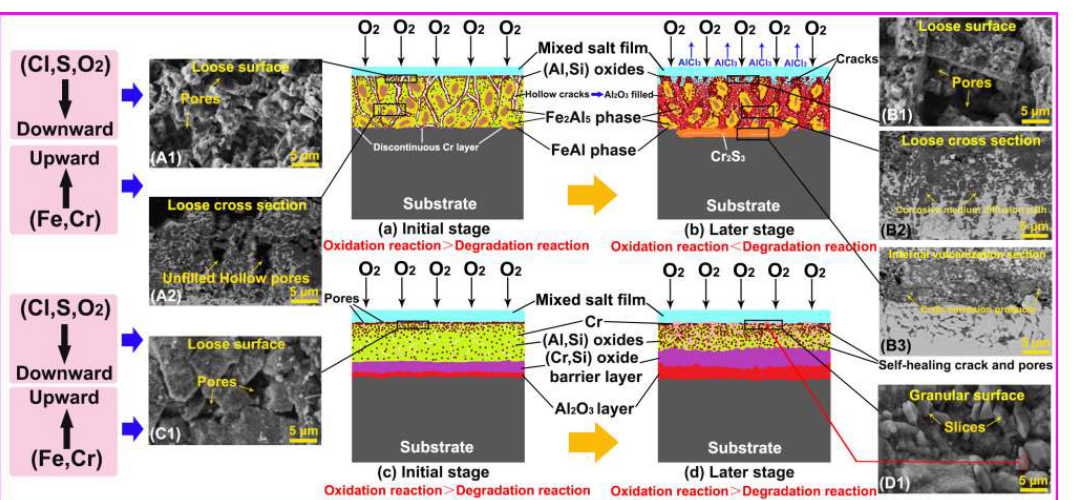
Figure 7. Schematic diagram of the degradation damage mechanisms of the as-deposited coatings during the hot-salt corrosion tests: ( a , b ) M1; ( c , d ) M2; SEM images of the surface of sample M1 after 100 h and 200 h hot salt corrosion: ( A1 ) and ( B1 ), SEM images of the cross section of sample M1 after 100 h and 200 h hot salt corrosion: ( A2 ) and ( B2 , B3 ); SEM images of the surface of sample M2 after hot salt corrosion for 100 h and 200h: ( C1 ) and ( D1 ).